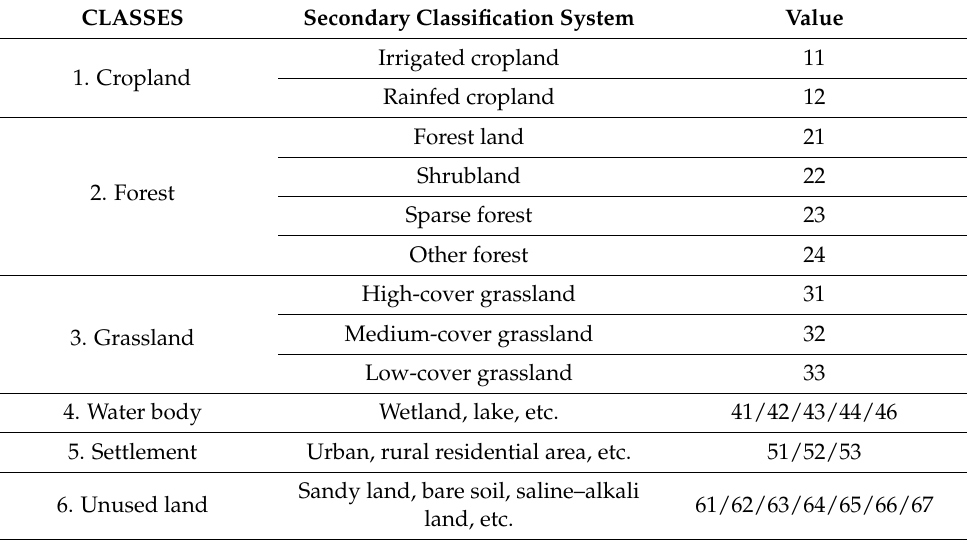
Table 1. The Classification System of the National Land Cover Types in